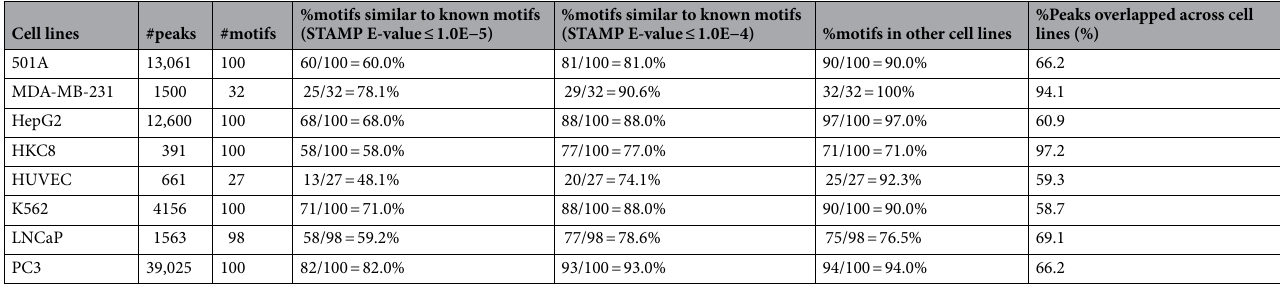
Table 1. The predicted motifs in eight cell